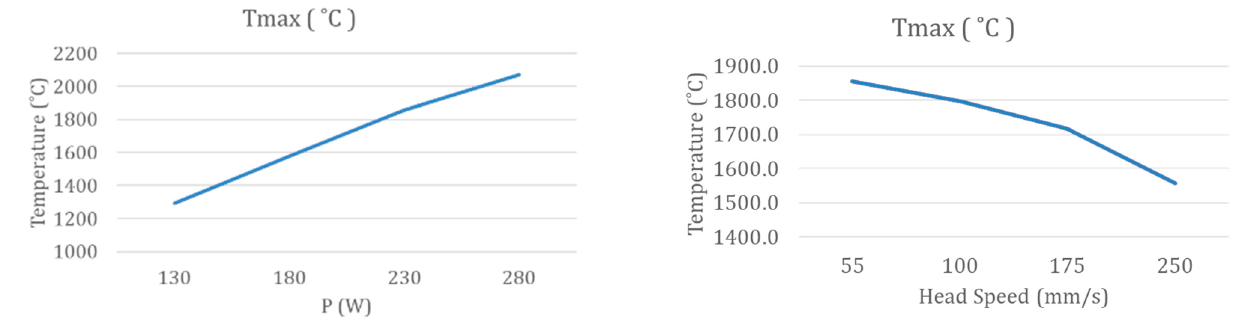
Figure 7. Examples of variables relationships in the case of metals AM.